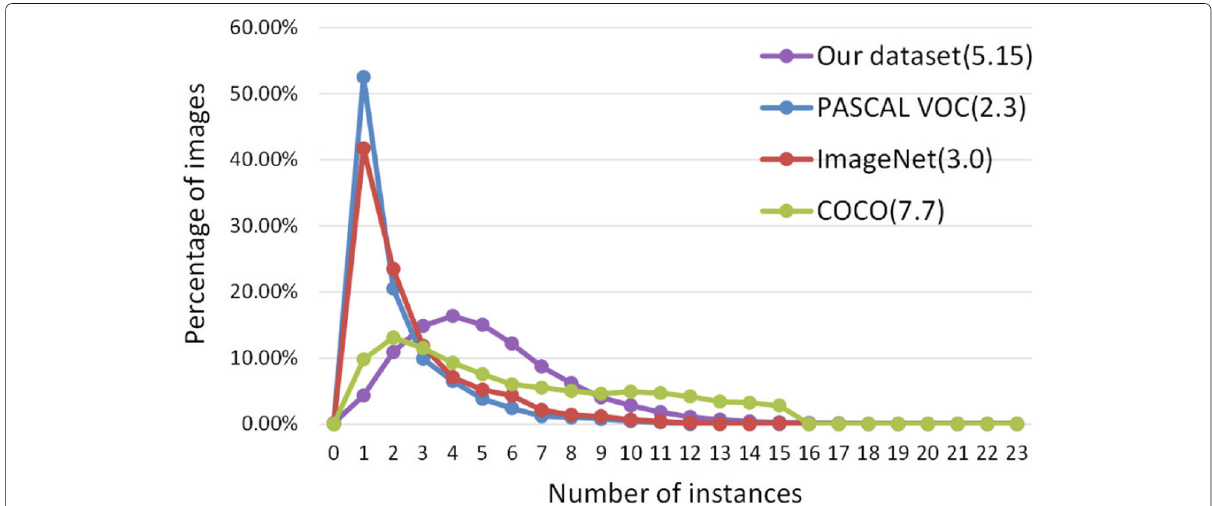
Fig. 3 Annotated instances per image (average numbers of annotated instances are shown in parentheses)